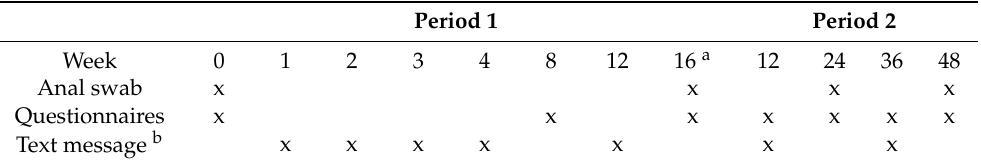
Table 1. Schedule of study follow-up during period 1 and period